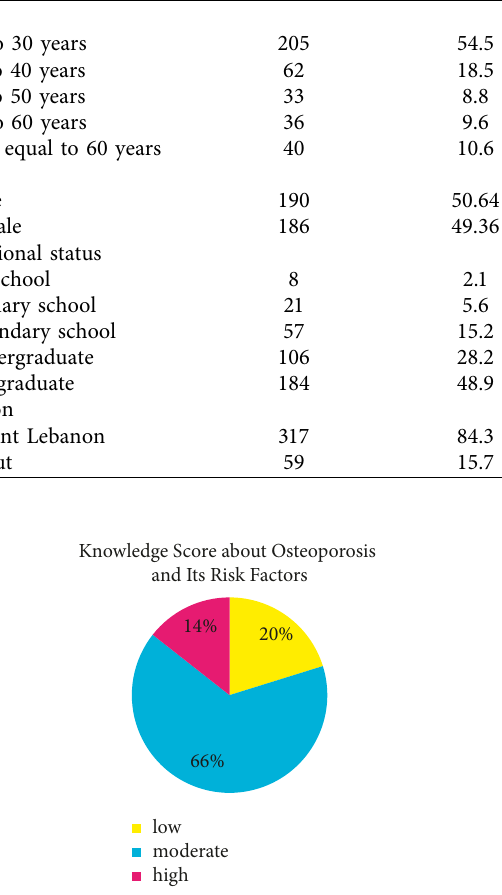
Figure 2: Knowledge score about osteoporosis and its risk factors.